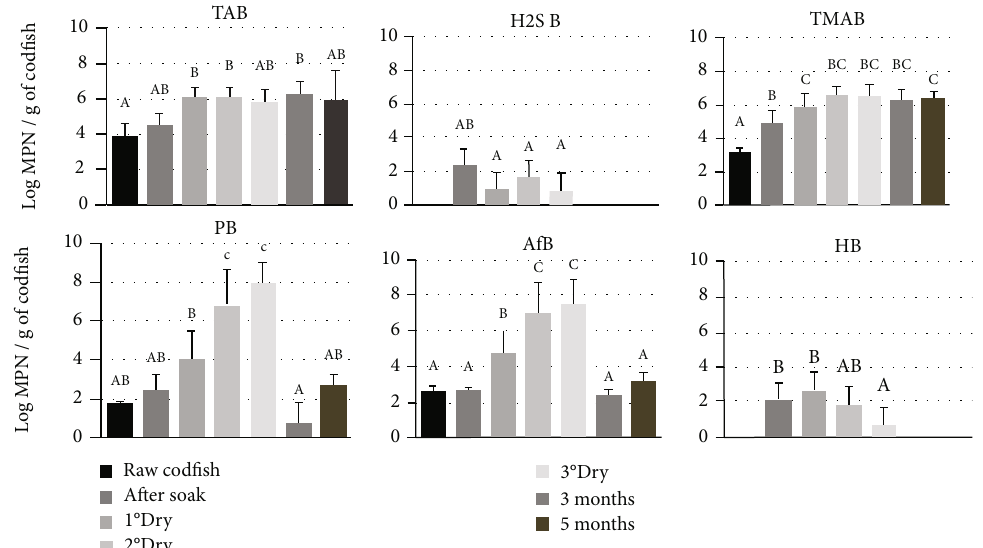
Figure 2: Change in abundance of bacterial di ff erent functional groups during the curing process: TAB: total aerobes; H2SB: sulphite- reducing bacteria/growth in iron agar; TMAB: trimethylamine-producing bacteria; PB: proteolytic bacteria; AfB: ammonifying bacteria; HB: histamine-producing bacteria. Di ff erent letters show statistically signi fi cant di ff erences between processing stages ( p < 0 : 05